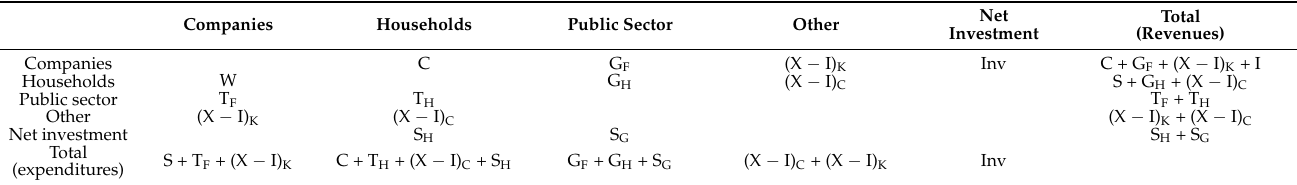
Table 1. Scheme of SAM. Source